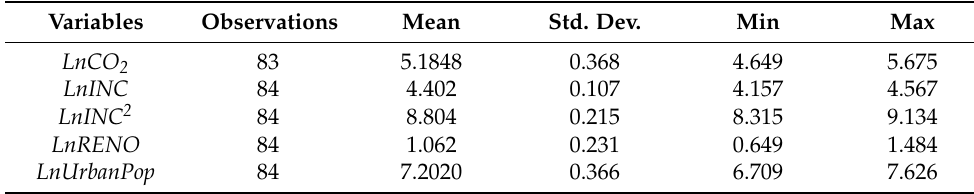
Table 2. Descriptive statistics. Variables Observations